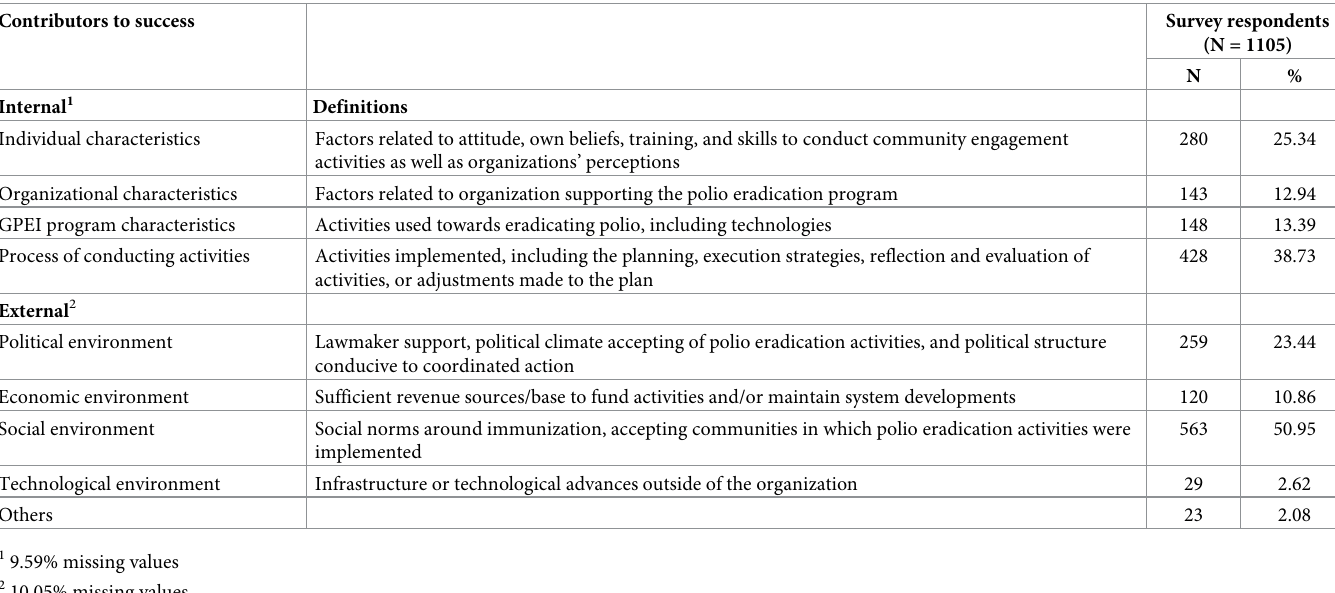
Table 3. Facilitators and barriers to community engagement